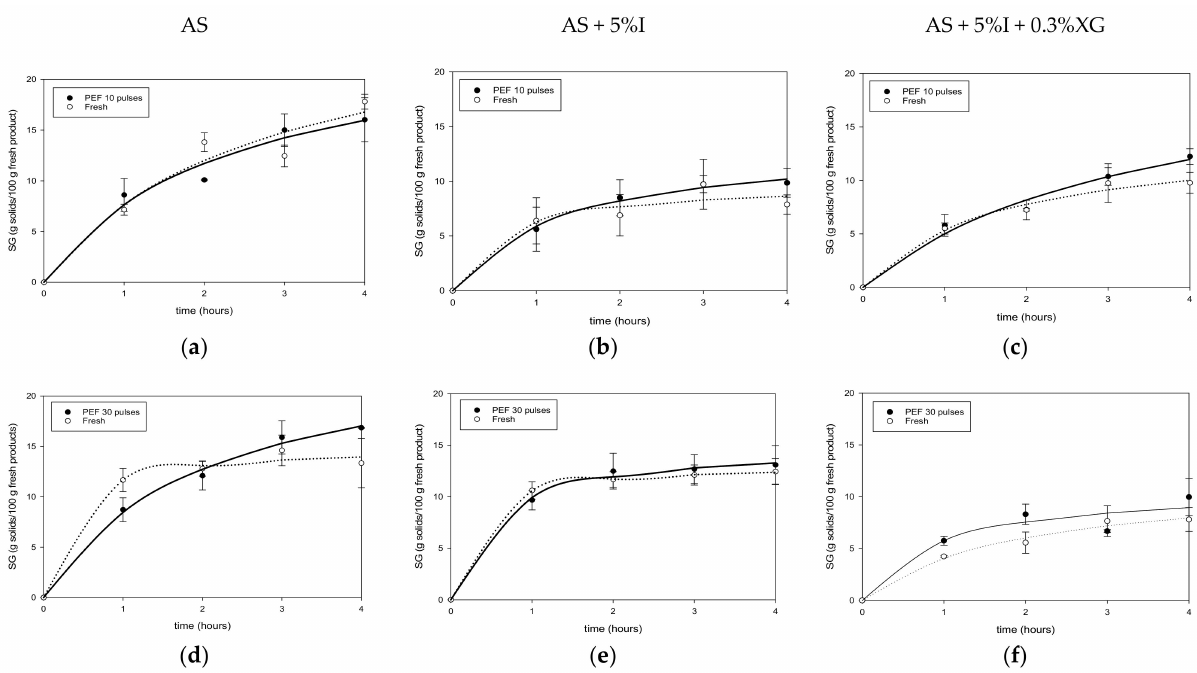
Figure 4. Solids gain of Fresh and PEF mango during osmotic dehydration in AS ( a , d ), AS + %I ( b , e ) and AS + %I + 0.3%XG ( c , f ) solutions.